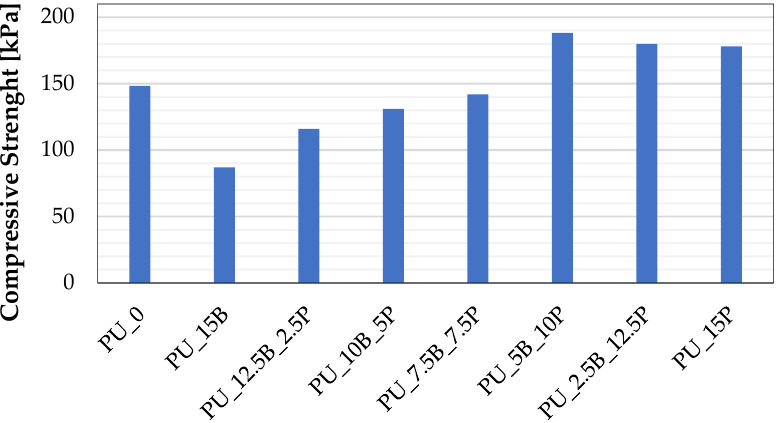
Figure 5. Compression strength of rigid PU foams containing buckwheat hulls and perlite.